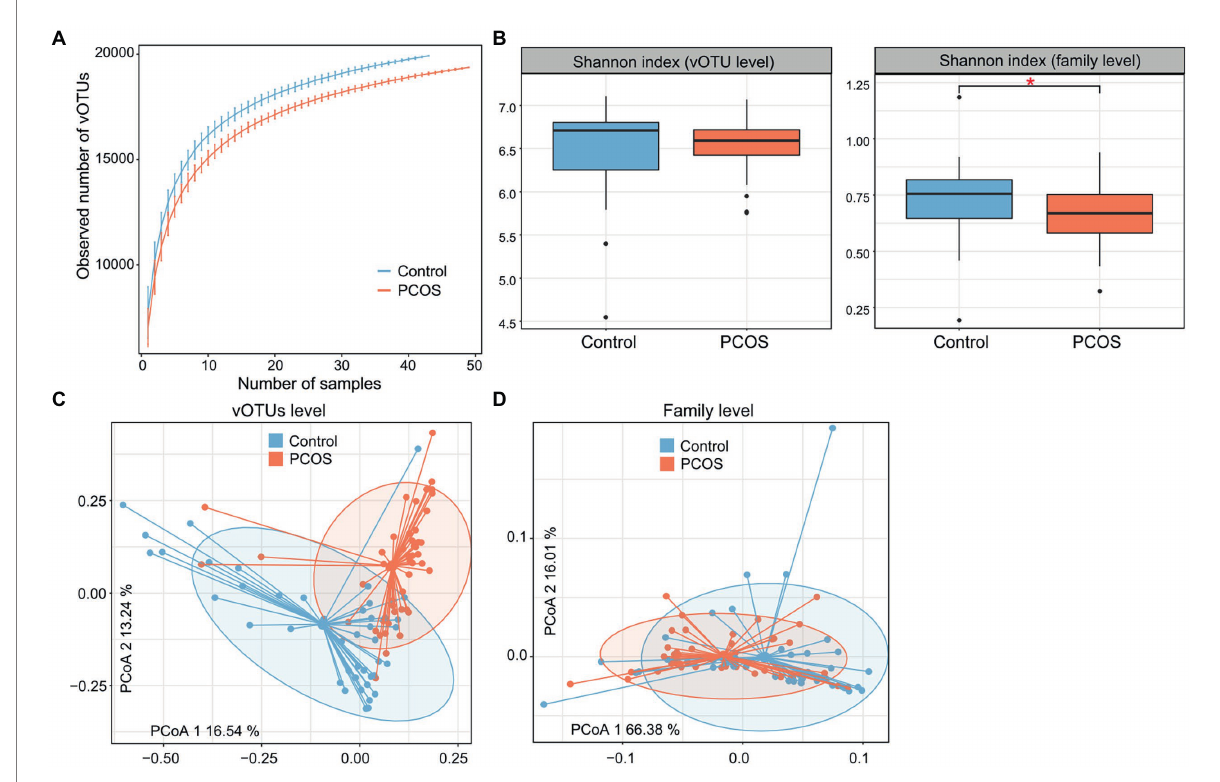
FIGURE 2 Diversity and PCoA analyses of the gut virome. (A) Rarefaction analysis showed an increase in the number of vOTUs observed as the number of random samples increased. (B) Boxplot showing the Shannon index of the gut virome of all samples at the vOTU and family levels. Boxes represent the interquartile range between the first and third quartiles and the median (internal line). Whiskers denote the lowest and highest values within 1.5 times the range of the first and third quartiles, respectively; dots represent outlier samples beyond the whiskers. (C,D) PCoA analysis of the Bray– Curtis distance of the gut virome at the vOTU (C) and family (D) levels. Samples are shown at the first and second principal coordinates (PC1 and PC2), and the ratio of variance contributed by these two PCs is shown. Ellipsoids represent a 95% confidence interval surrounding each